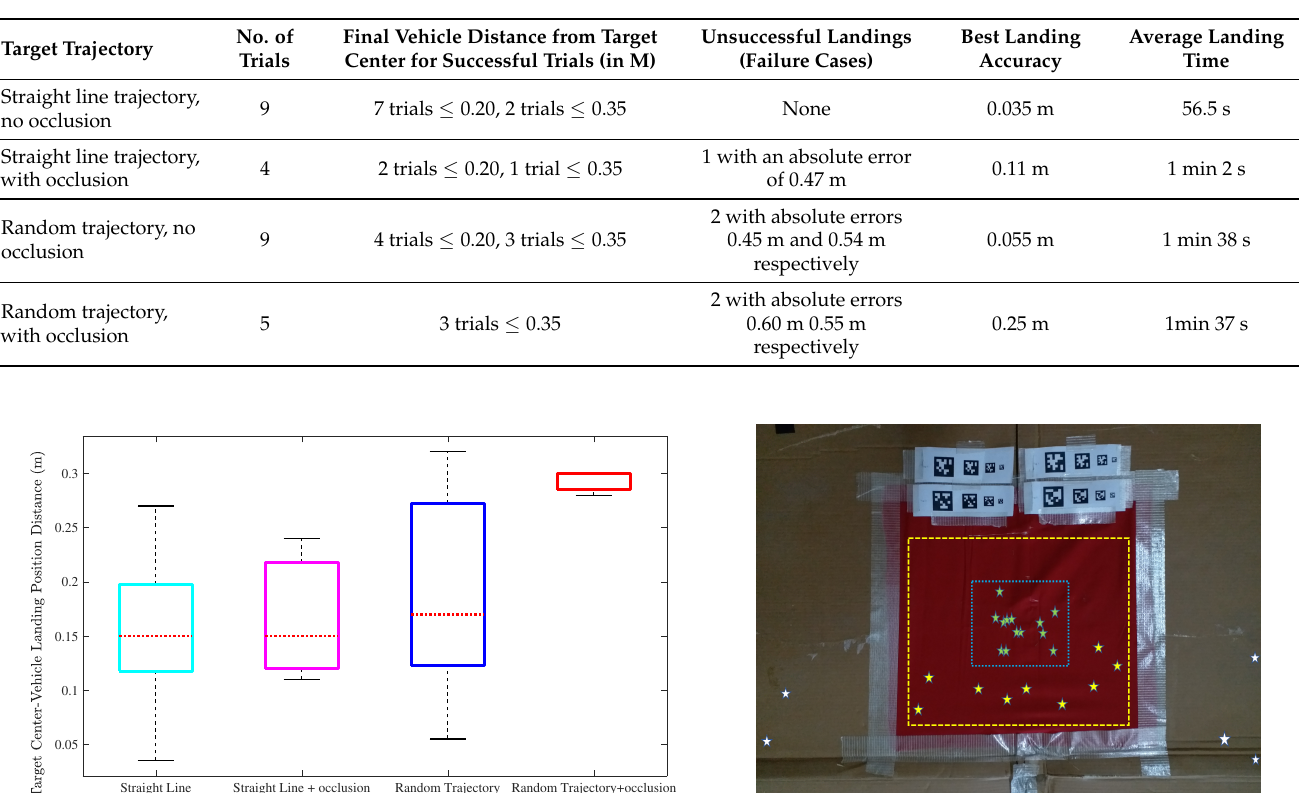
Table 1. Categorization of experimental trials according to target trajectory and target occlusion.